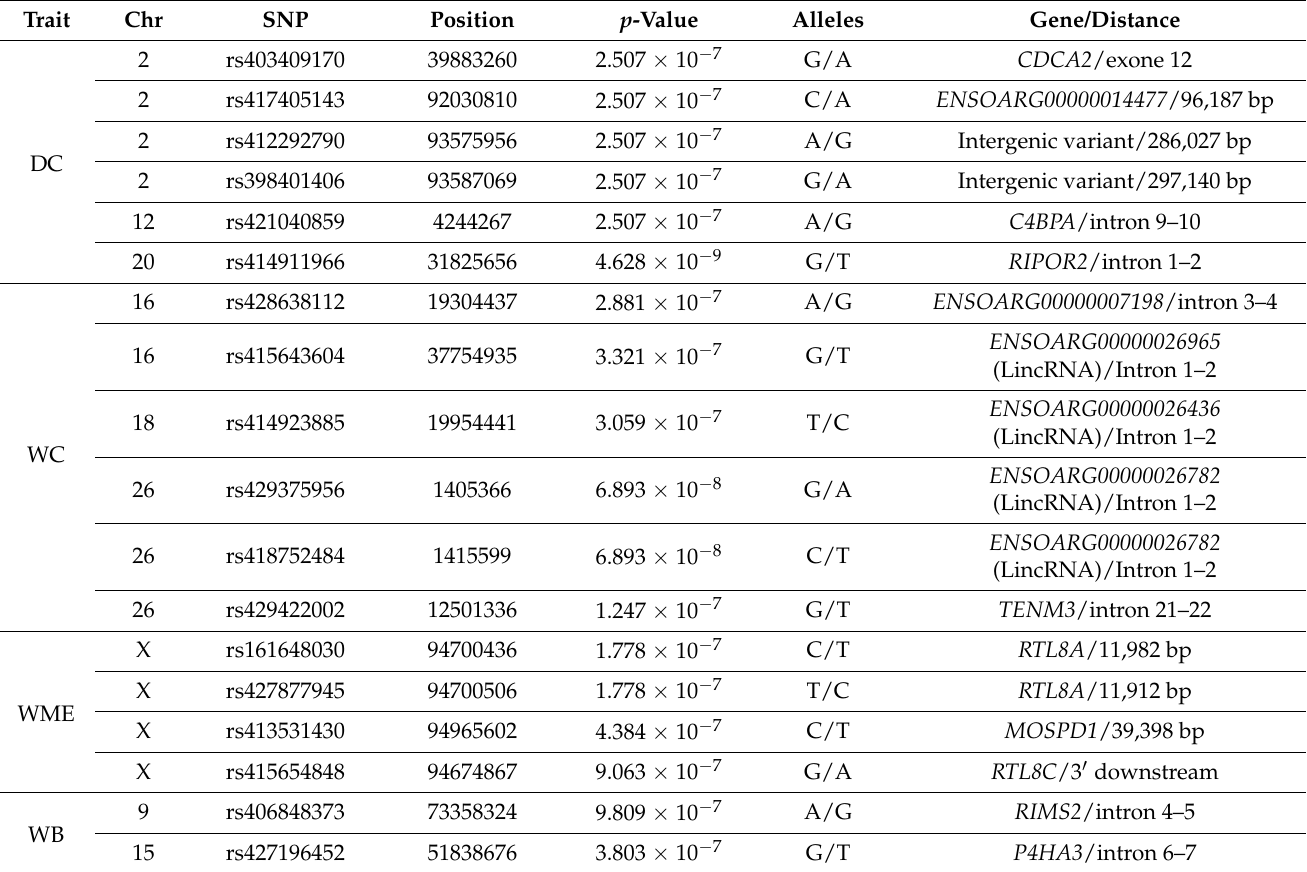
Table 2. Associated with meat production trait SNPs and candidate genes in Jalgin